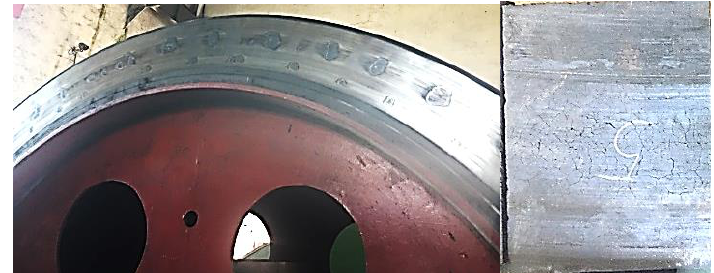
Figure 11. Surface damages of brake disc and brake shoe after emergency braking of coal mine hoist with high speed and heavy load.